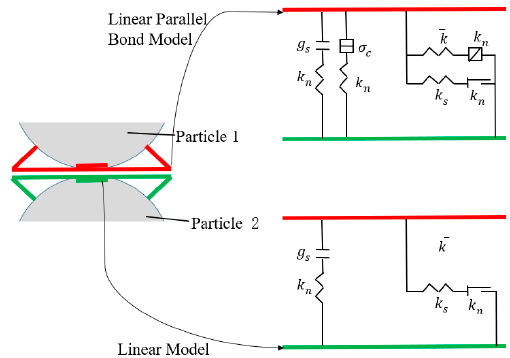
Figure 4. Composition diagram of parallel bond contact model.